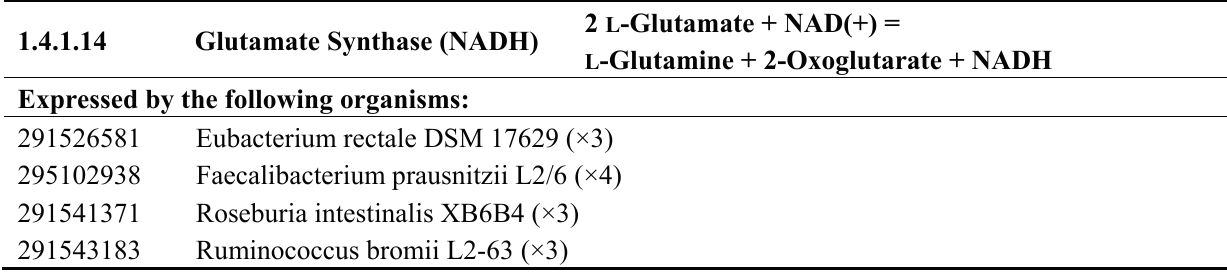
Table 7. Glutamate synthase expression (“control” unique).